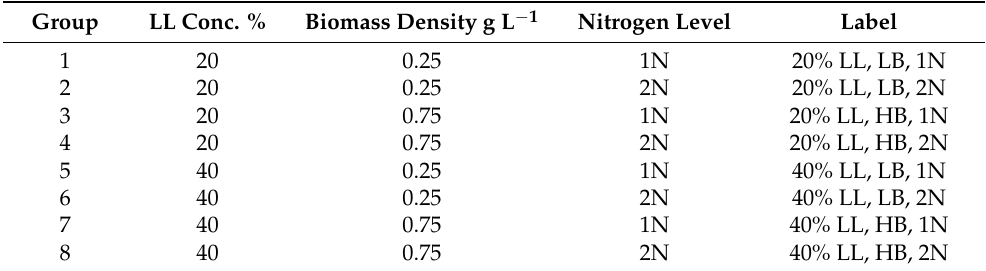
Table 2. Media compositions for Experiment 1. For the convenience of discussion, biomass densities of 0.25 g L − 1 and 0.75 g L − 1 are represented as low biomass (LB) and high biomass (HB), respectively. Group LL Conc. % Biomass Density g L − 1 Nitrogen Level